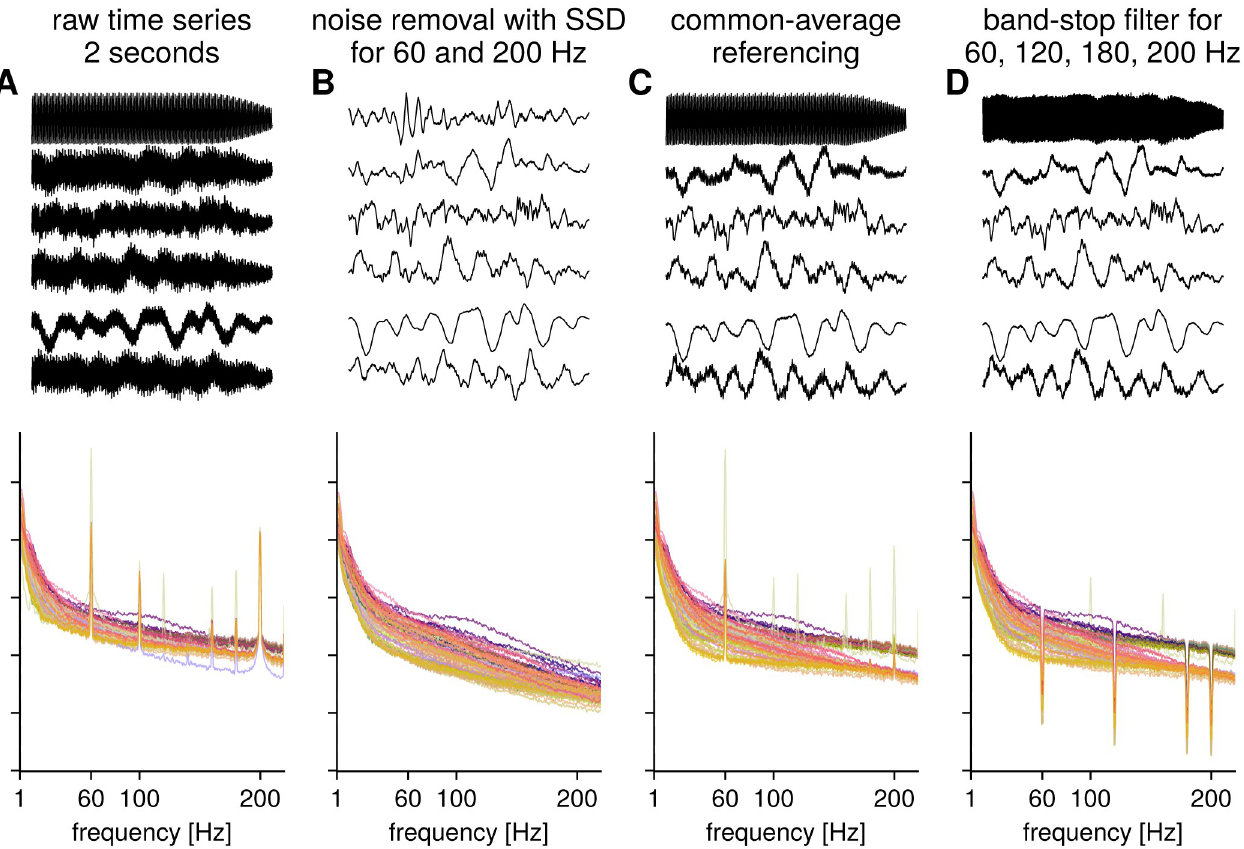
Fig 7. Illustration: Removal of noise with spatial filters for ECoG data. A) Time series of six electrodes and power spectra for raw ECoG recording for 87 electrodes, color code corresponds to electrode position, with neighboring electrodes having a similar color. B) Time series and power spectra after removal of components maximizing SNR for 60 Hz and 200 Hz spectral peaks. Note that there are no band-stop type artefacts in the spectrum since no temporal filtering was performed. C) Time series and power spectra after common average referencing. While the 200 Hz noise is largely attenuated, 60 Hz line noise still persists. D) Time series and power spectra after common average referencing and then band-stop filtering. The band-stop filters introduce artefacts in the spectral domain.